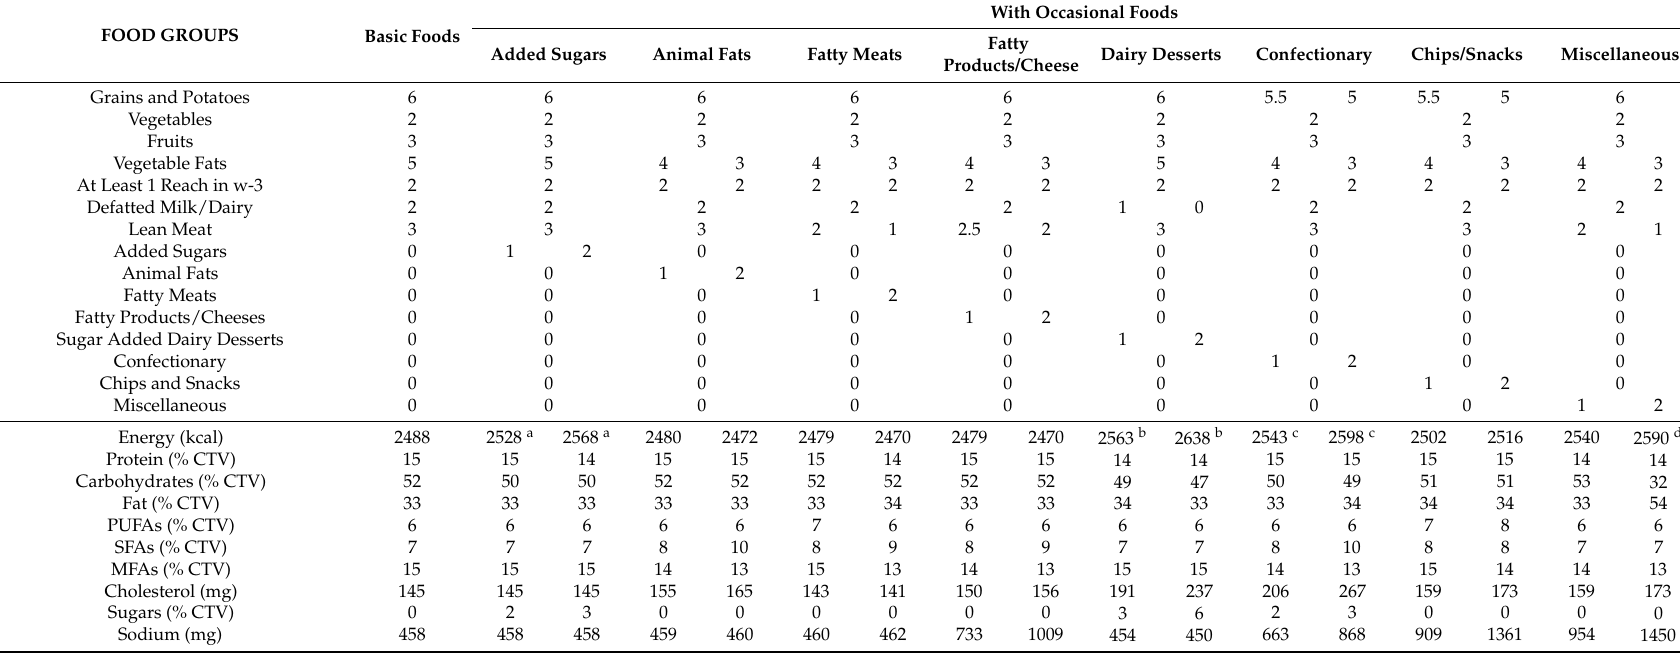
Table 7. Suggested number of servings for occasional foods at 2500